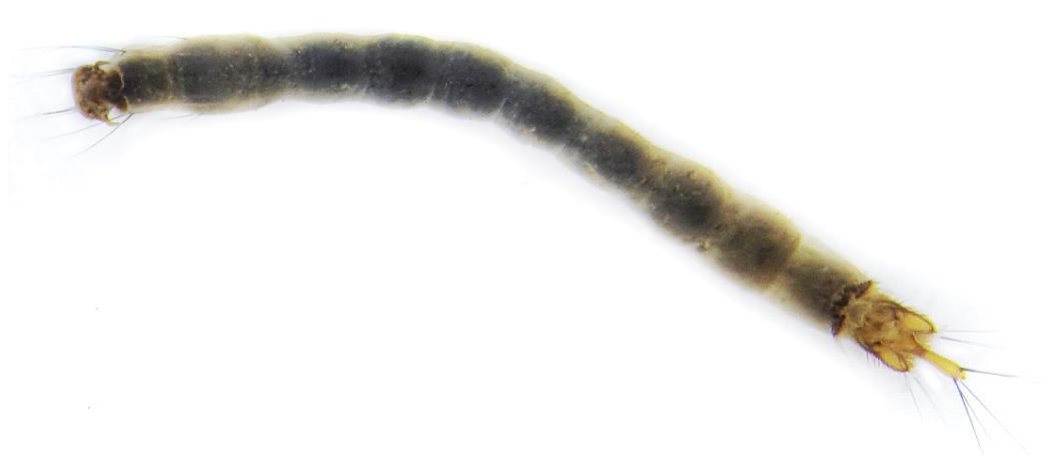
Figure 2. Dixella aestivalis (Meigen, 1818) dorsal view (photo by P. Simović,